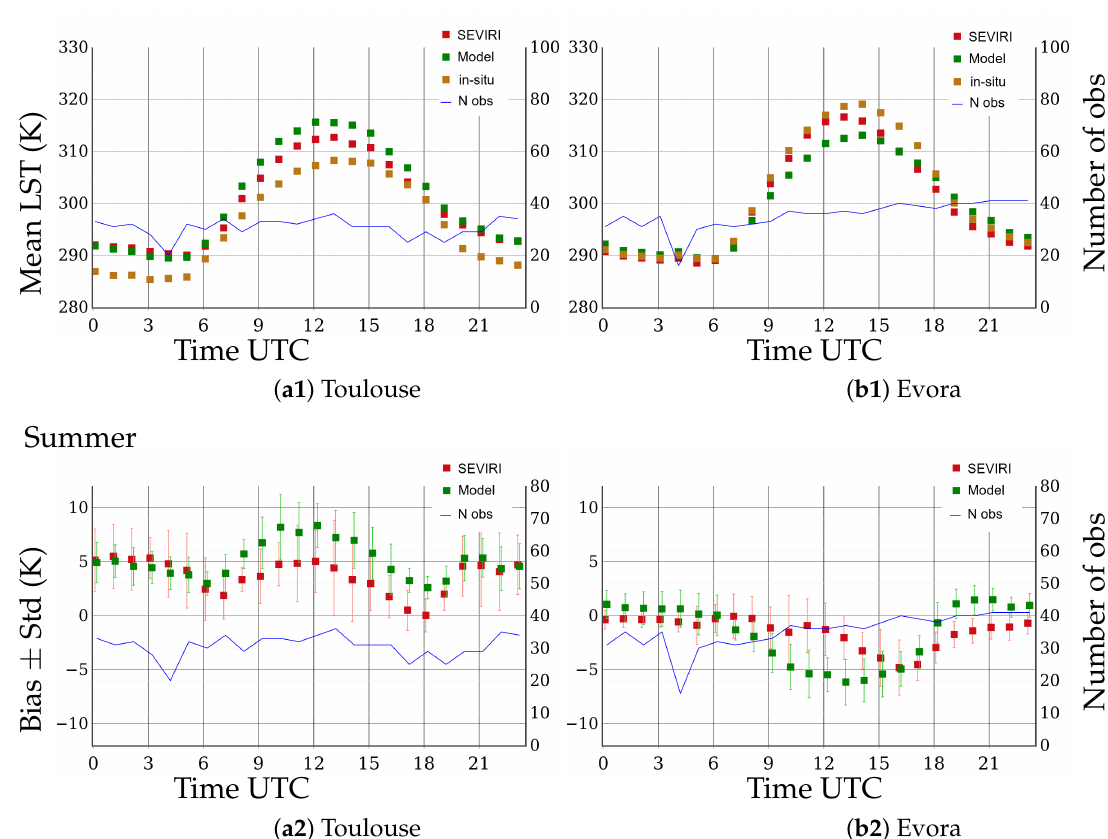
Figure 3. Diurnal variability of surface mean temperature (K) from SEVIRI (red), model 1 h forecast (green) and local observation (brown) during summer period (July & August 2018) for Toulouse station ( a1 ) and Evora station ( b1 ) and statistics of differences of SEVIRI LSTs (red) and Model LSTs (green) minus observation for Toulouse station ( a2 ) and Evora station ( b2 ): the markers describe the bias while the bars describe the associated standard deviation. The blue line shows the number of SEVIRI/model LST used